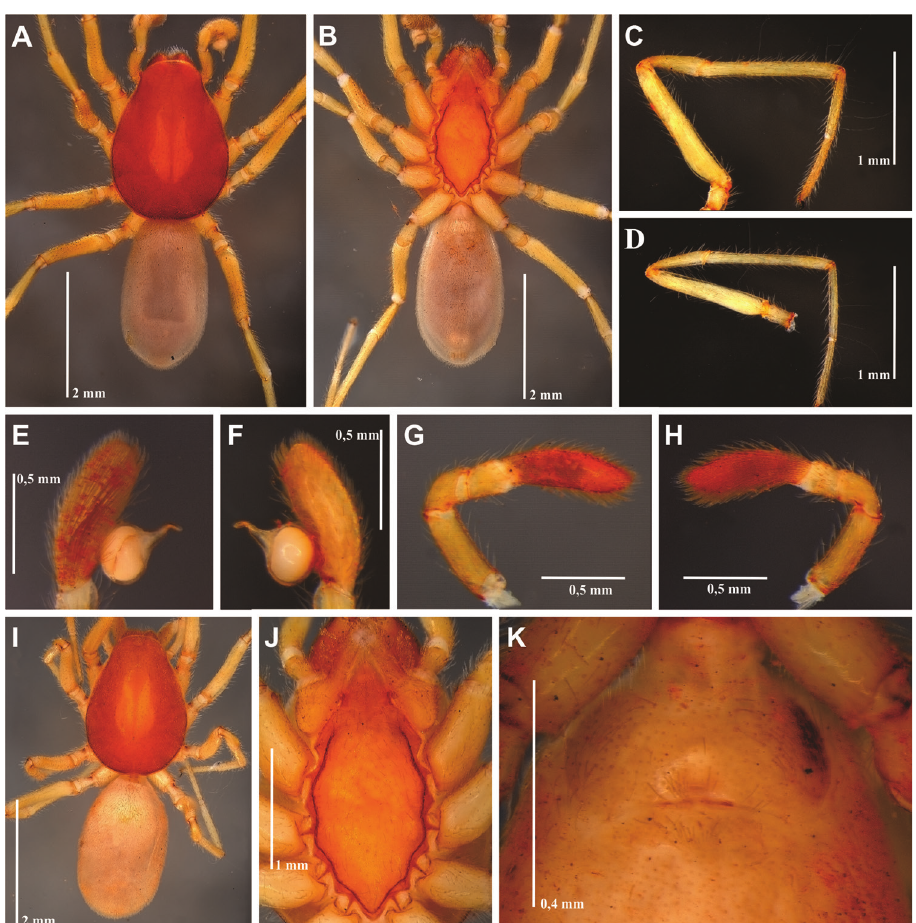
Figure 13. Carajas paraua sp. n., male ( A–F ) and female ( G–K ) from Parauapebas, Pará. A habitus dorsal view B same, ventral view C left leg I, prolateral view D left leg IV, prolateral view E left pedipalp, prolateral view F same, retrolateral view G left pedipalp prolateral view H same, retrolateral view I habi- tus, dorsal view J carapace, ventral view K genital area, ventral view. patella 1.0/ tibia 1.4/ metatarsus 1.1/ tarsus 1.0/ total 6.3; II: 1.6/ 1.0/ 1.4/ 1.0/